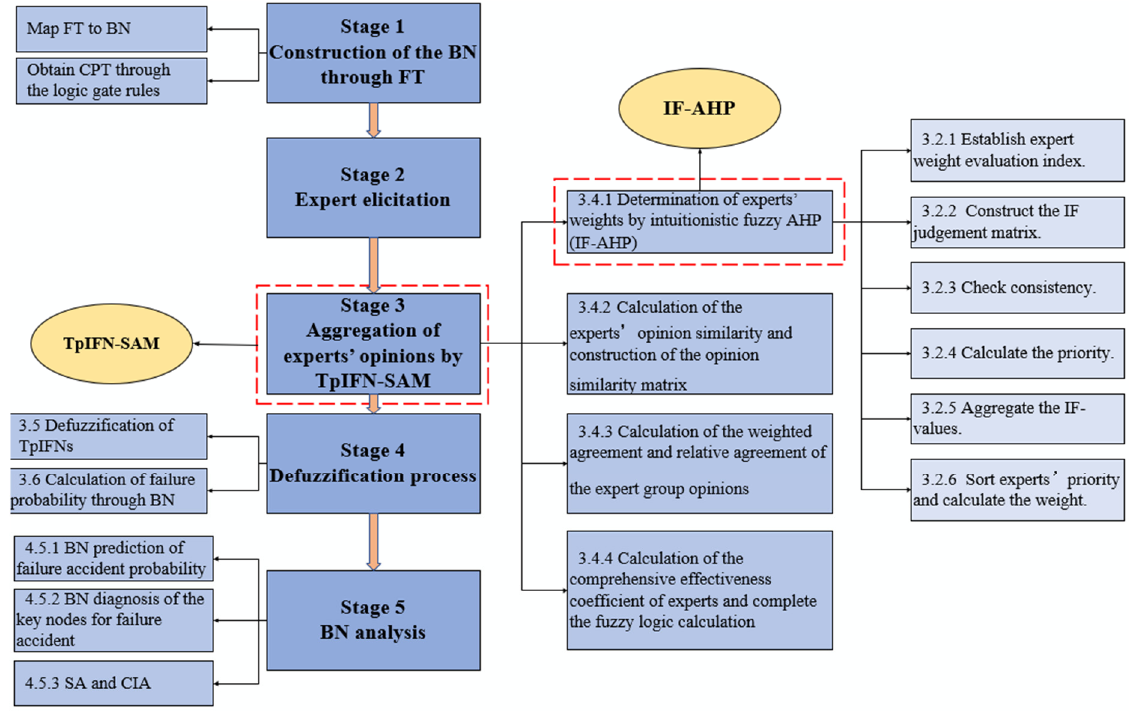
Figure 4. The proposed analysis